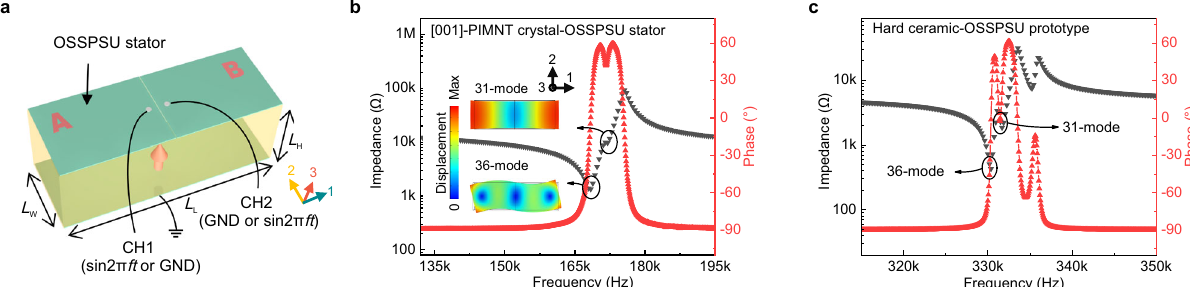
Fig. 4 | Schematic, electric impedance and phase spectra of the 31 – 36 coupled mode OSSPSU stator. a The stator schematic image. The red arrow shows the direction of poling. b The impedance and phase spectra of [001]-PIMNT crystal-